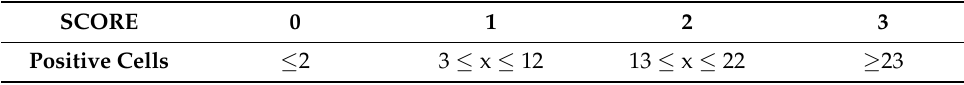
Table 2. Scoring system for immunohistochemical